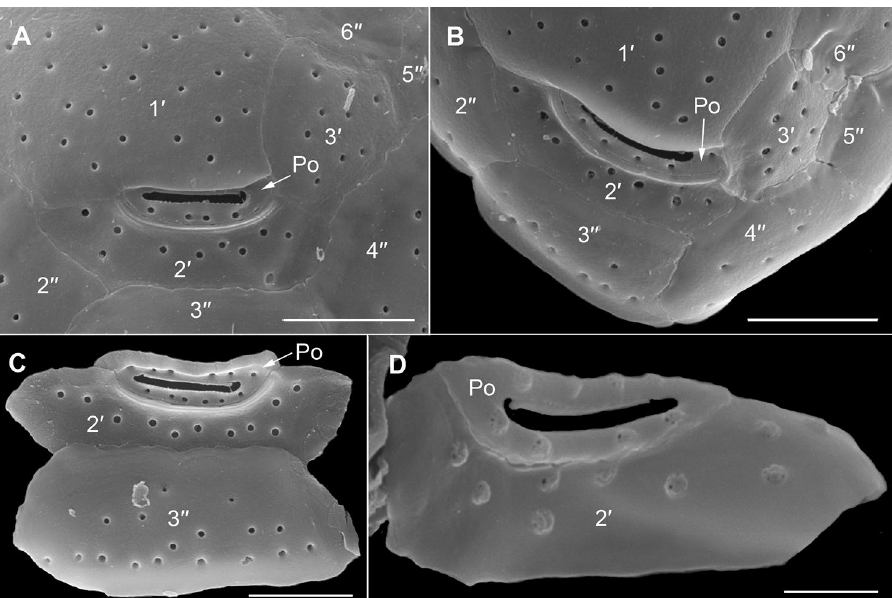
Figure 13. Scanning electron micrographs of Coolia tropicalis strain C11C2 showing details of the apical pore complex and surrounding epithecal plates. ( A,B ) Dorsal part of the epitheca showing the apical pore plate (Po) with nearly straight slit-like apical pore. ( C ) Separated epithecal plates, including the Po plate with round thecal pores surrounding the slit-like apical pore. ( D ) Inside view the apical pore plate (Po) with inner covering of the thecal pores perforated by tiny irregular openings. Scale bars = 5.0 µm, except D: 2 µm.